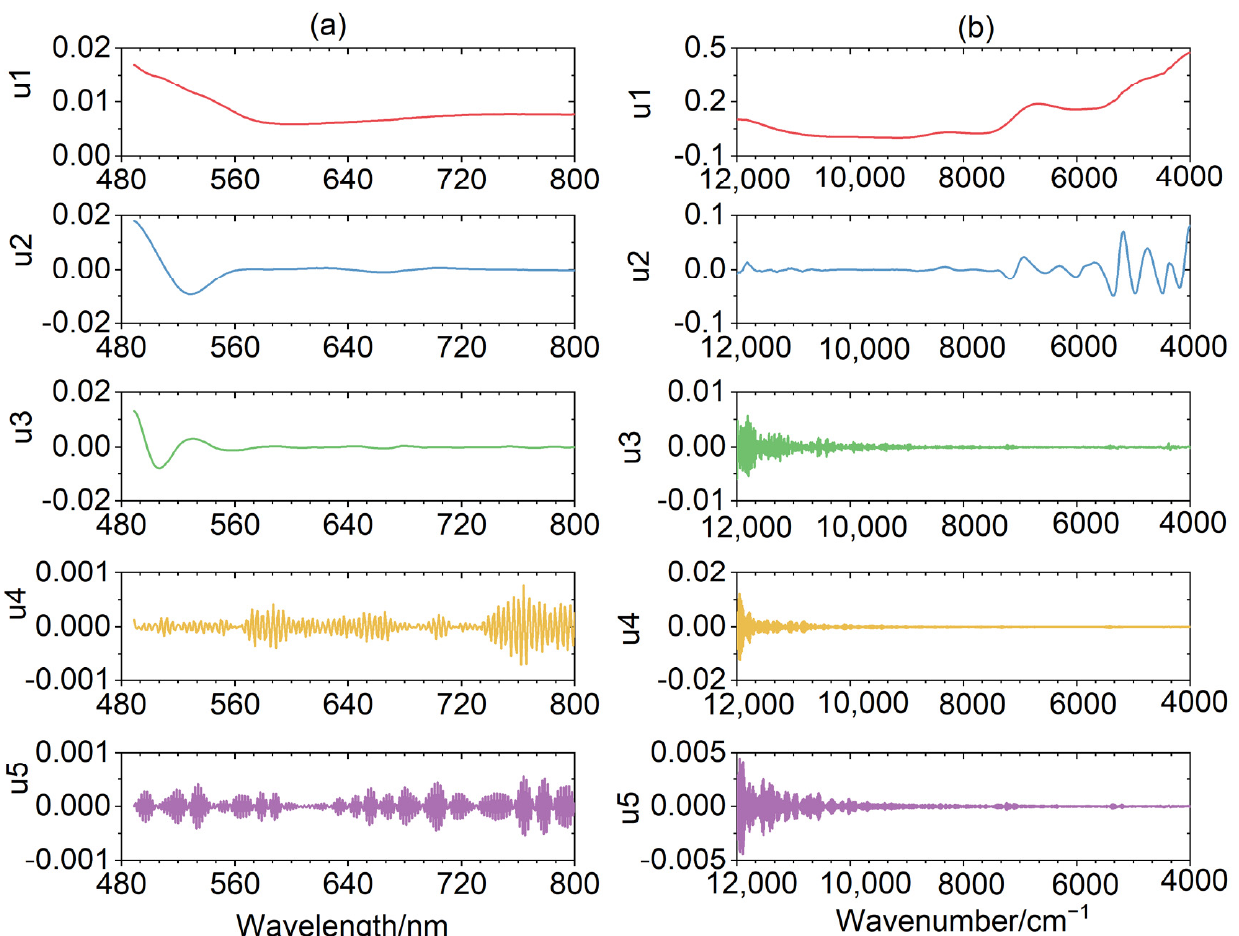
Figure 4. VMD diagram of the spectrum for sample No. 2 in the adulterated vegetable oil ( a ) and sample No. 17 in the adulterated herb ( b ) datasets.